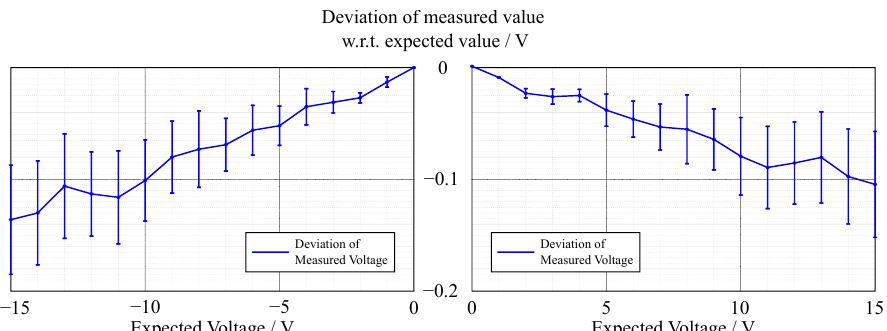
Figure 3. Absolute deviation of the voltage as measured by the sensor box with regard to the expected value.